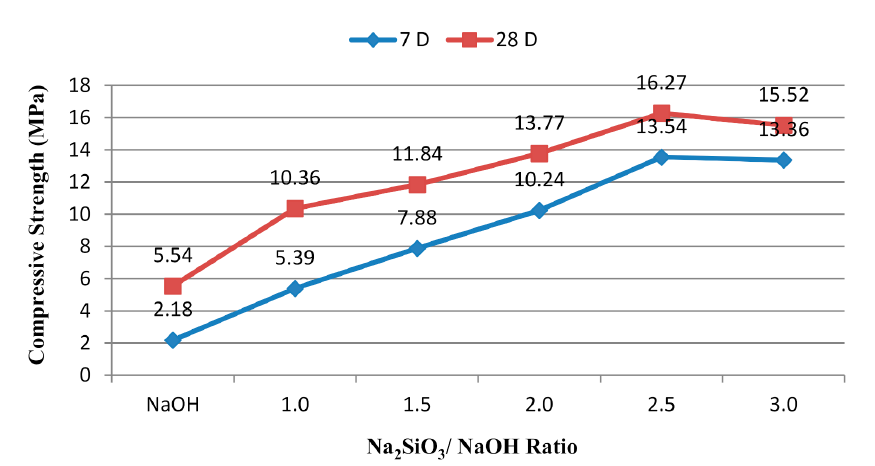
Figure 9. Compressive strength of alkali-activated POFA paste at different Na 2 SiO 3 /NaOH